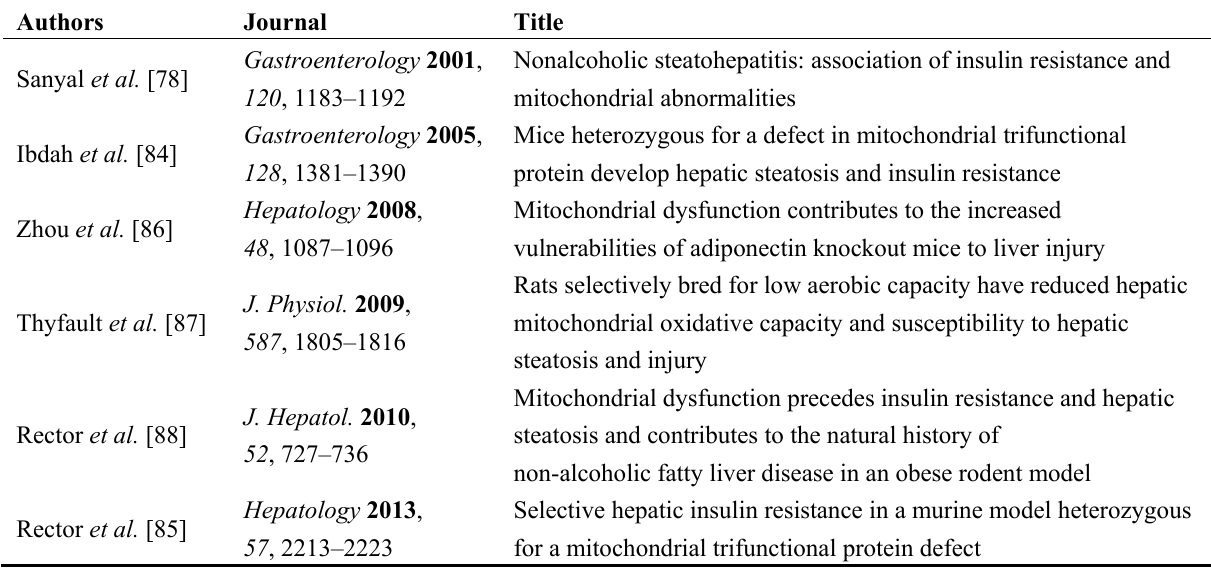
Table 1. Selected published reports on the role of mitochondria in